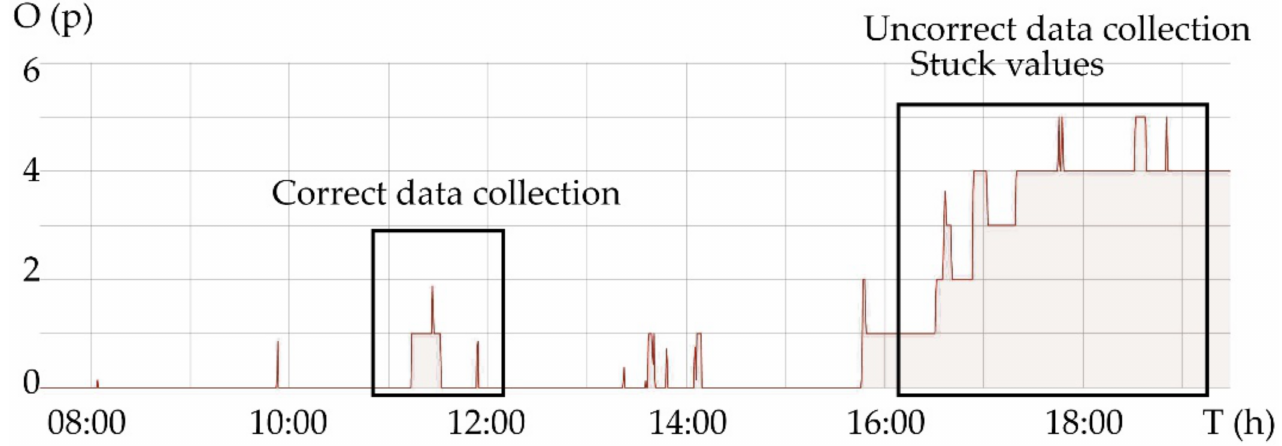
Figure 7. Graph of collected data regarding occupancy overtime in a bathroom (O-T).